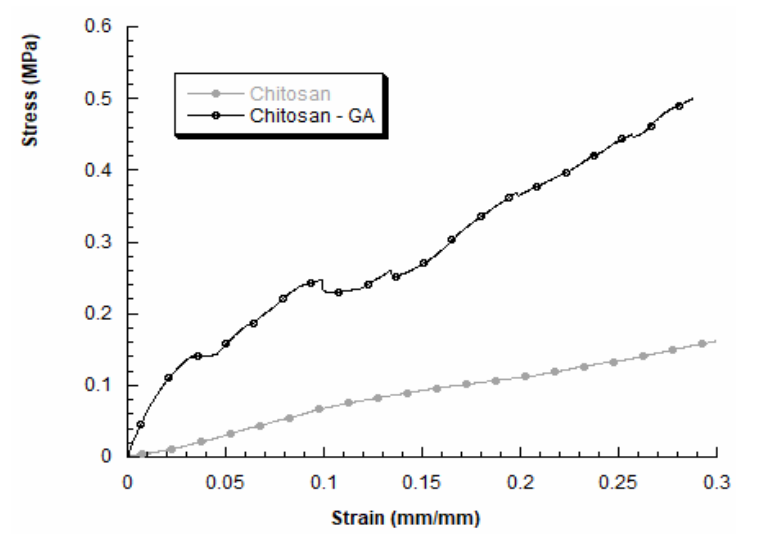
Figure 3. Stress–strain curves obtained for 3D chitosan before and after incubation with 23.5 mM GA to obtain the HL-3D chitosan-GA complex. Table 4. Compressive modulus E and maximum stress ( σ max ) at a strain level of 0.3 mm/mm for 3D chitosan and HL-3D chitosan-GA complex.